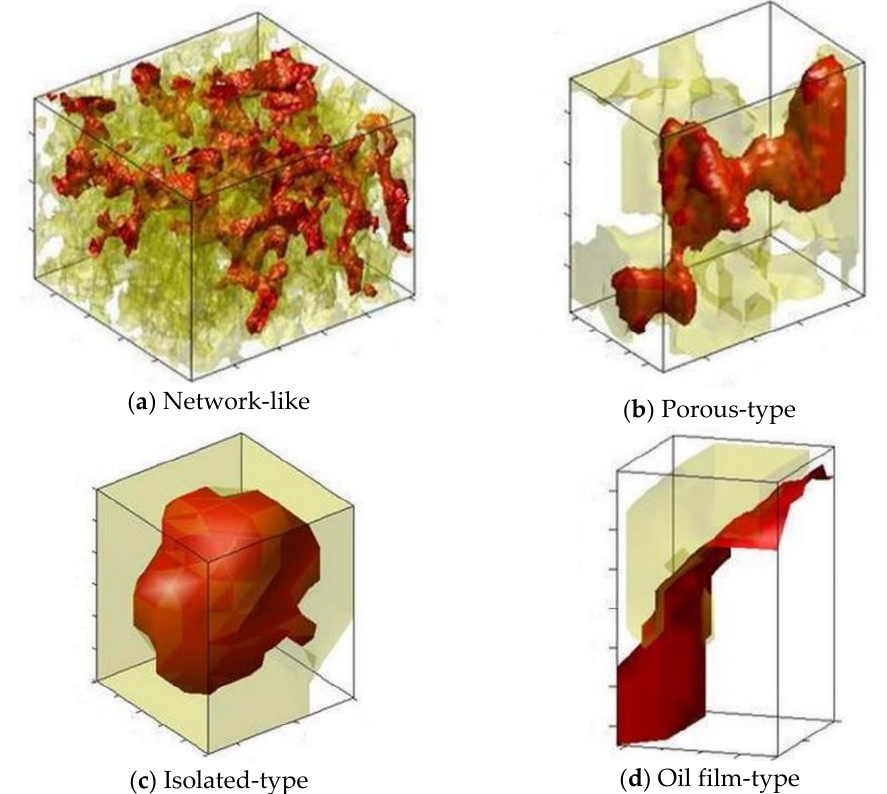
Figure 3. Classification of pore-scale oil morphology in rock samples.